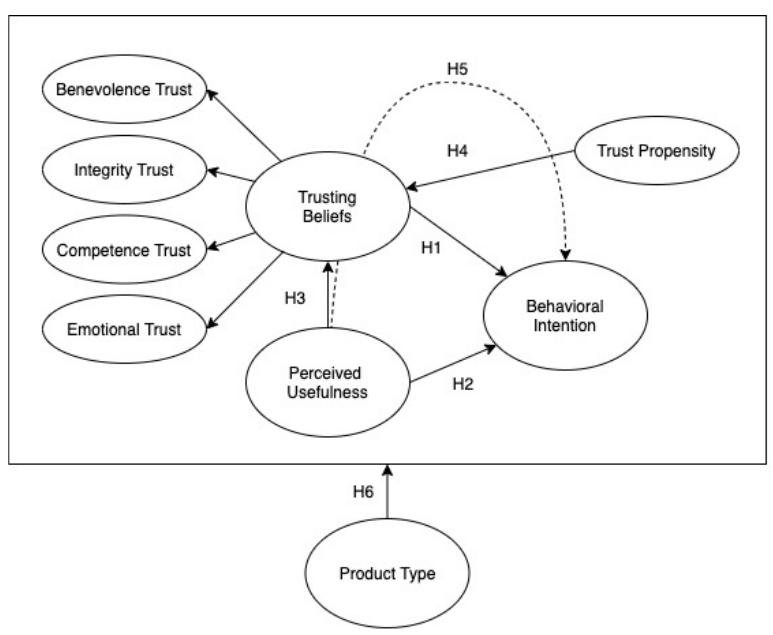
Figure 1. Overview of the research model and hypotheses.